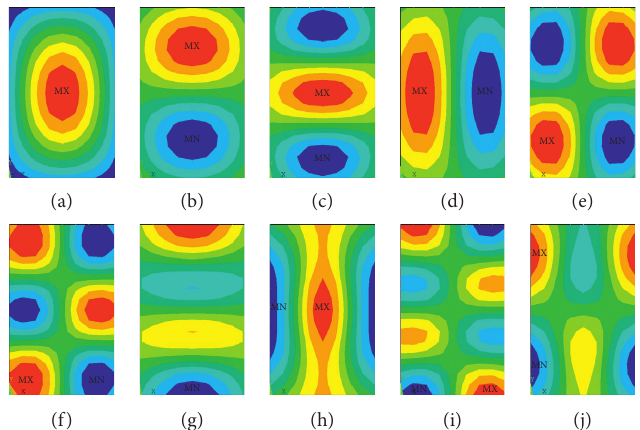
Figure 2: The first 10 mode shapes and corresponding natural frequencies: (a) the 1st mode (19.120Hz); (b) the 2nd mode (32.937 Hz); (c) the 3rd mode (55.019Hz); (d) the 4th mode (55.099 Hz); (e) the 5th mode (64.120Hz); (f) the 6th mode (80.449 Hz); (g) the 7th mode (80.749 Hz); (h) the 8th mode (95.982Hz); (i) the 9th mode (103.05Hz); (j) the 10th mode (104.06Hz).